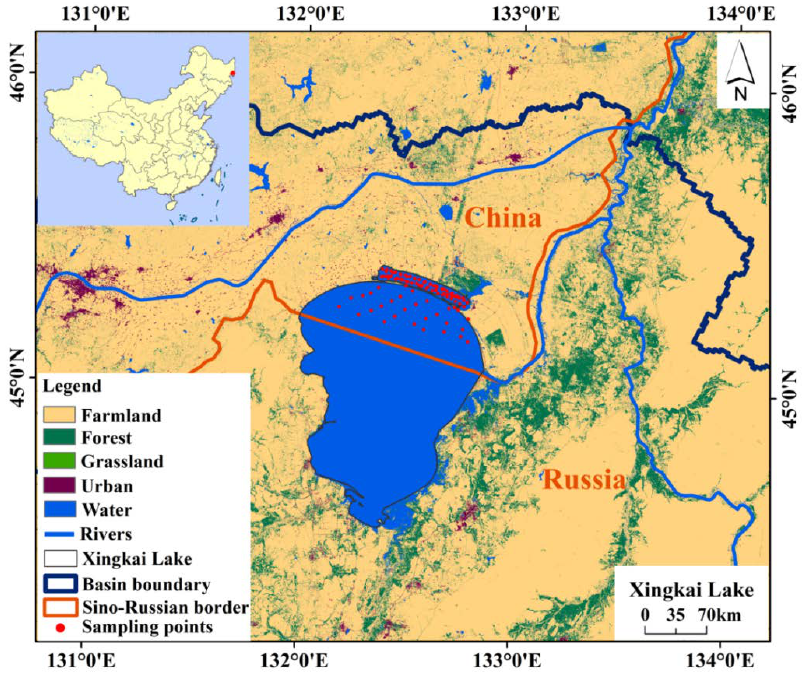
Figure 1. Study area and distribution of sampling sites.